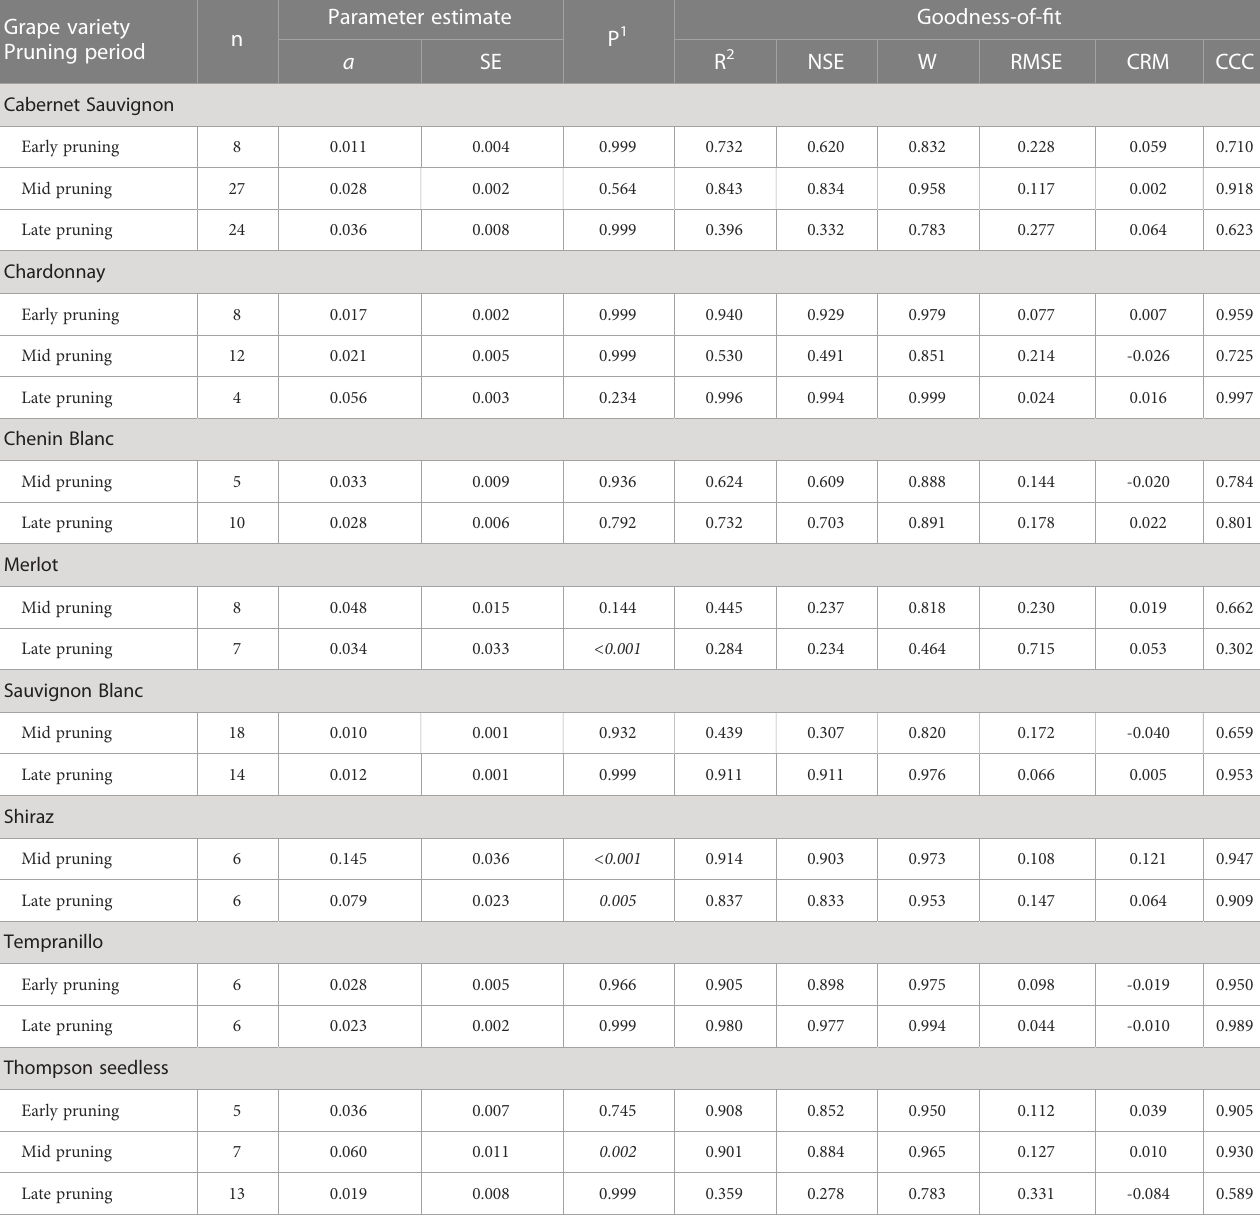
TABLE 5 Parameters and statistics of goodness-of- fi t for equation [1] (see text), which predicts pruning wound susceptibility as a function of time after pruning when wounds were inoculated for subsets of the data that concern the interaction between grape variety and pruning period. Grape variety Pruning